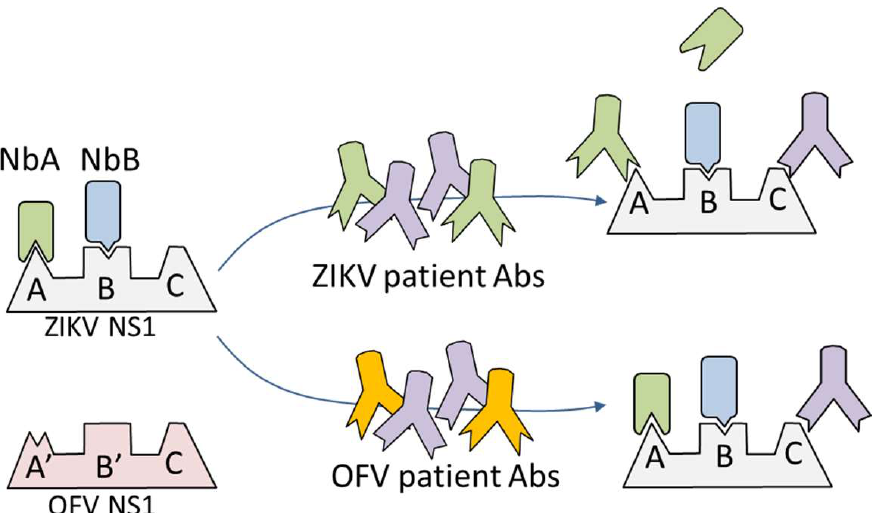
Figure 1. The Non-Structural 1 (NS1) protein from Zika and other flaviviruses (OFV) has some unique epitopes (A, B and A (cid:48) , B (cid:48) , respectively) and shares others (represented by C). For the development of a blocking of binding assay, the competing antibodies need to fulfill two conditions: they must react with a ZIKV NS1-specific epitope and that epitope must be immunogenic in human infections with the virus. In the scheme, antibody NbA and NbB do react with unique epitopes, but NbB recognizes an epitope that is not immunogenic in humans and, therefore, there are no blocking antibodies in the serum of the infected patients. Hence, only NbA is suited to develop a blocking of binding assay. The recombinant fragment (nanobodies) derived from the variable domain (VHH) of heavy-chain-only antibodies, found in camelids, has salient biotechnological properties and can be readily reproduced from sequences [19]. These antibodies possess numerous advantages for immunoassay development compared to conventional antibodies, such as high soluble expression levels, small size, excellent thermal stability, simple genetic manipulation, among others [20–22]. In the past, we developed high-throughput